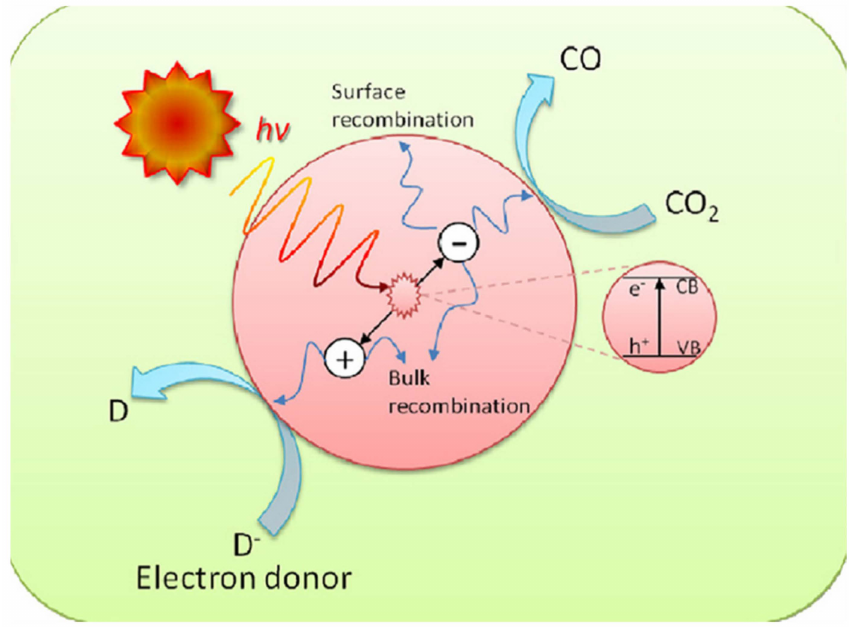
Figure 6. Schematic representation of photoexcitation and electron transfer process. Reprinted with permission from Elsevier, 18 December 2021 Ref. [49].